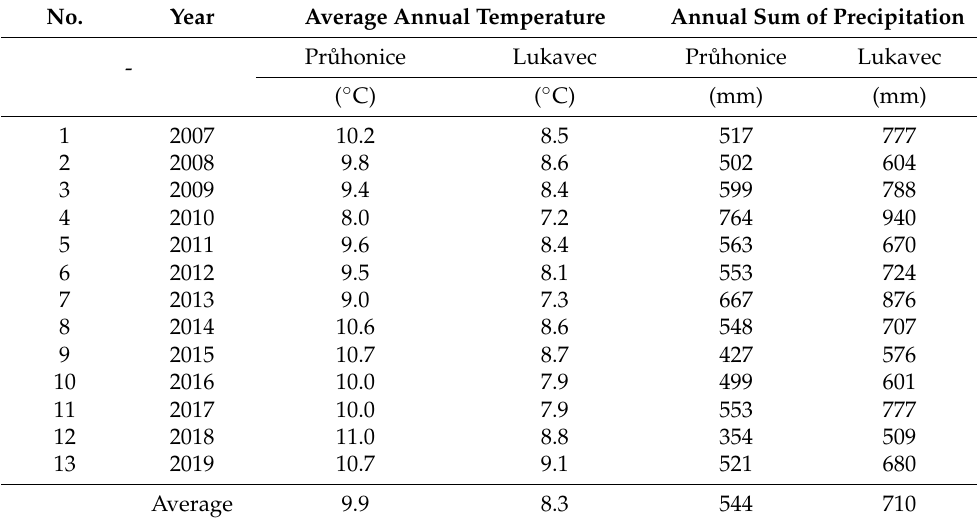
Table 2. Annual temperatures and precipitations in Pr˚uhonice and Lukavec between 2007–2017. No.